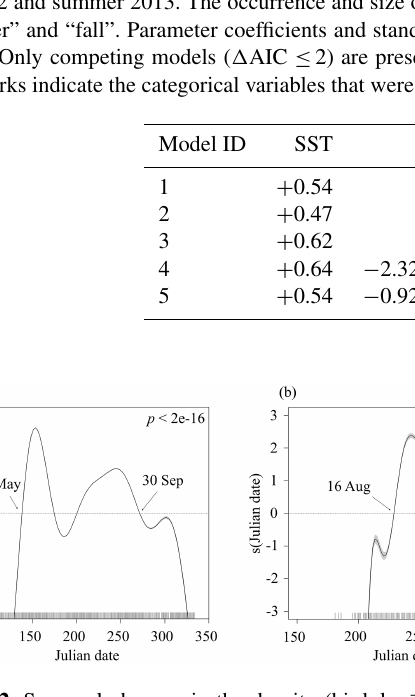
Figure 2. Seasonal changes in the density (birdskm − 2 ) of short- tailed shearwaters ( Ardenna tenuirostris ) in the Bering Sea (a) and Chukchi Sea (b) . Densities were estimated using a generalized ad- ditive model (GAM). Gray shading indicates 95% confidence limits and thick marks on the x axis indicate the locations of data points. Significance levels ( p values) are shown on each